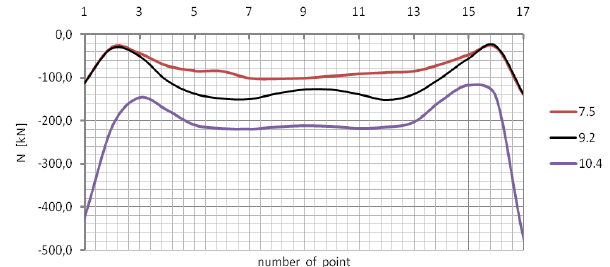
Figure 6: Diagrams of axial forces with regards to the backfill thickness z g